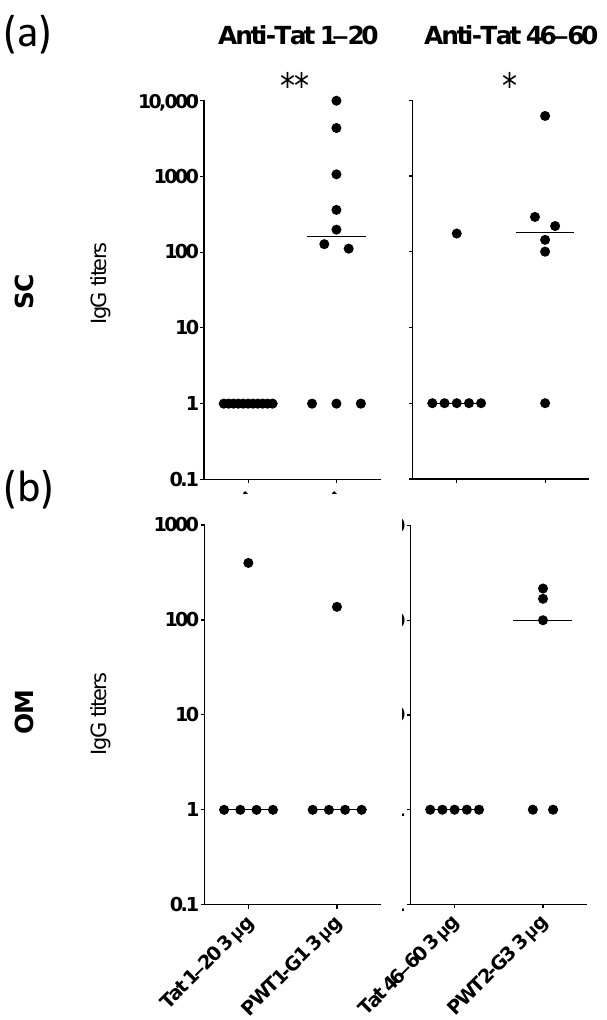
Figure 3. Analysis of IgG responses induced by Tat peptides alone or Tat peptides conjugated to PWT scaffolds. Mice were immunized on three separate occasions with 3 µ g of Tat 1–20 , PWT1-G1, Tat 46–60 , or PWT2-G3 delivered either SC ( a ) or via the OM ( b ). Serum samples were collected 2 weeks after the final immunization. IgG titers specific for Tat 1–20 or Tat 46–60 were measured via ELISA. Each dot represents one mouse, and horizontal bars indicate median values. Significance was